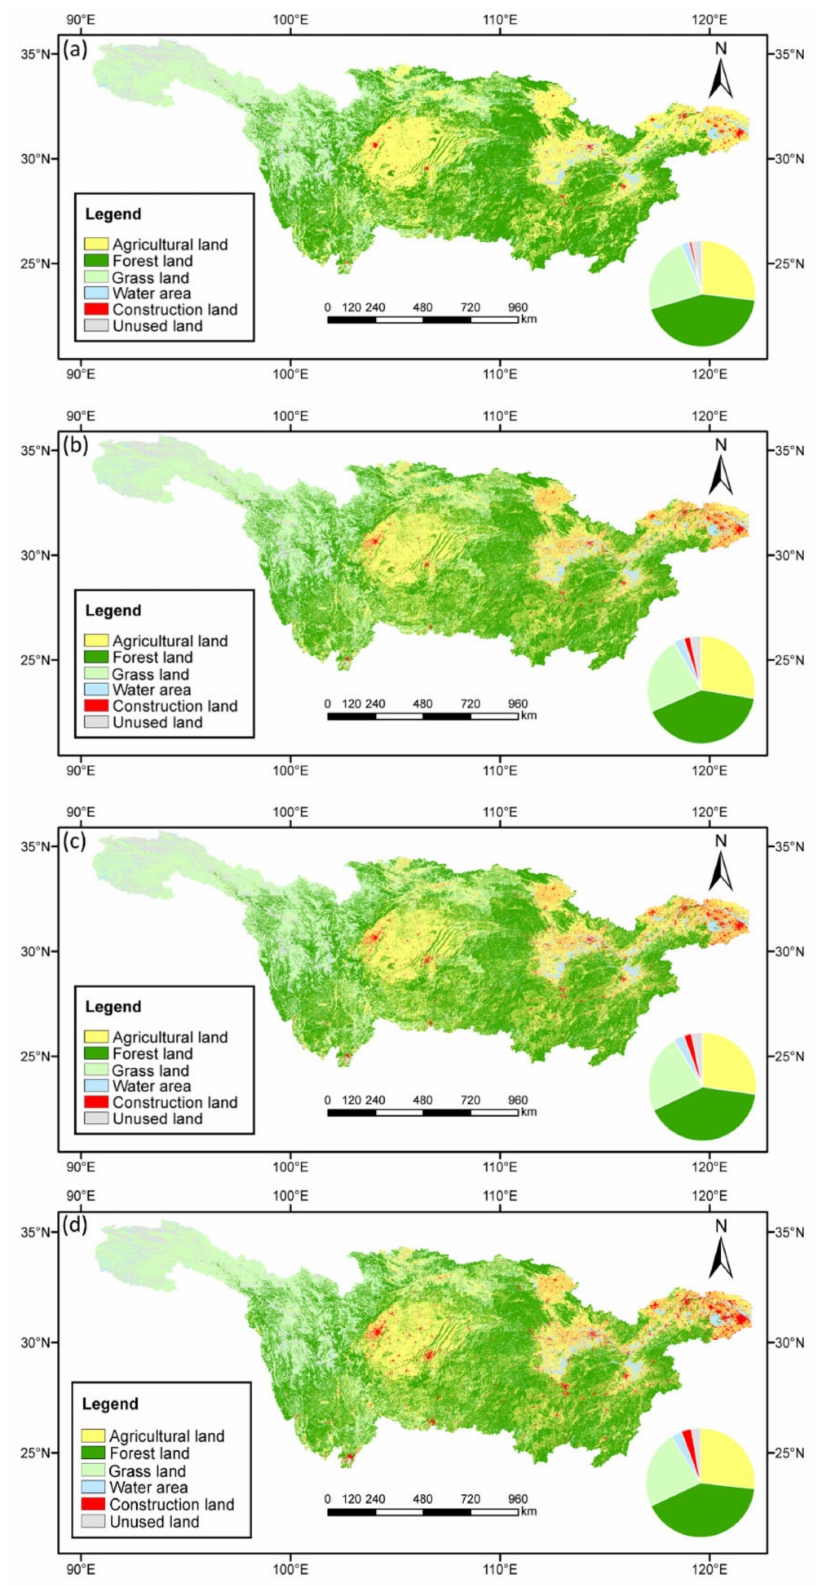
Figure 9. Land use distribution in 2005 ( a ), 2010 ( b ), 2015 ( c ), and 2018 ( d